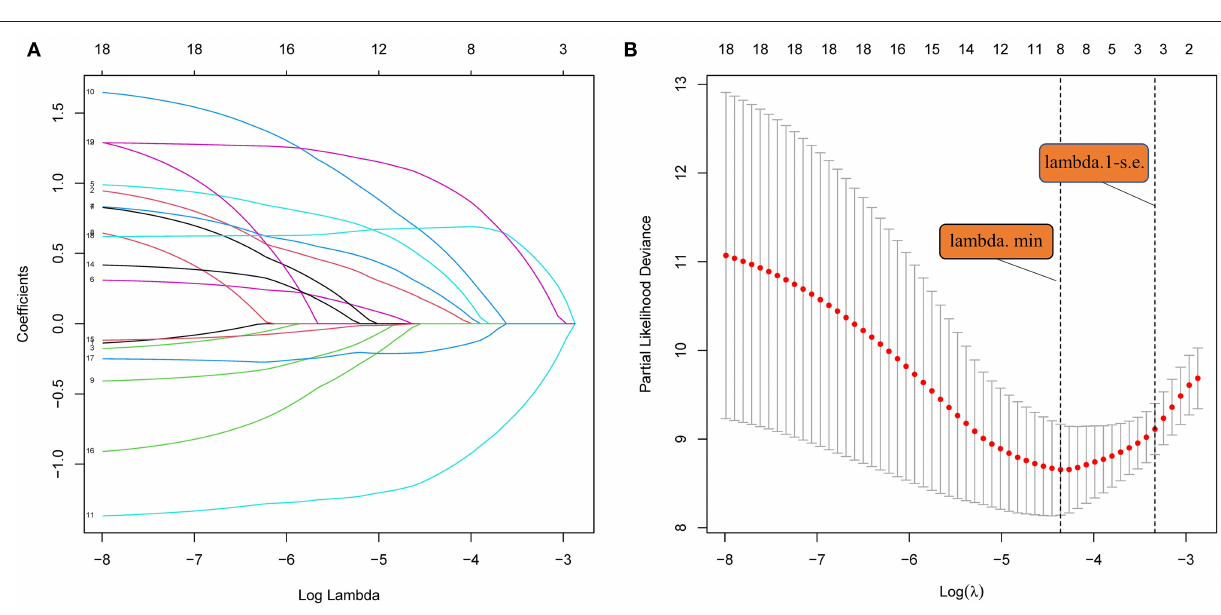
FIGURE 3 | (A) LASSO coefficient profiles of the 18 risk factors. (B) Risk factors selected using LASSO regression analysis. The two dotted lines were drawn at the optimal scores by minimum criteria and 1-s.e. criteria (at minimum criteria, including age, diabetes, hypertension, RLS, ALB, PA, hsCRP, and Hcy at 1-s.e. criteria, including ALB, hsCRP, and